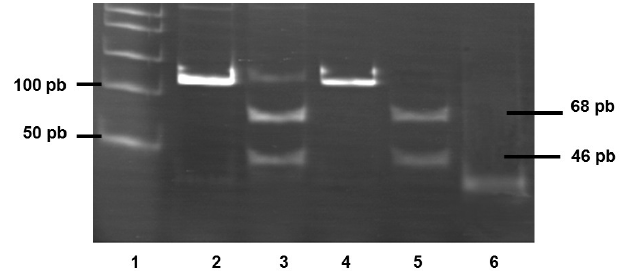
FIGURE 2 - PCR products of FLT3-D835, analyzed by gel electrophoresis. Reverse view of ethidium-bromide-stained 12% polyacrylamide gel FLT3-D835 was detected as extra- band after enzymatic digestion in addition to normal bands of 68 bp and 46 bp. Line 1- Molecular weight marker (50 bp); Line 2-PCR product of a patient sample with FLT3-D835 mutation before enzymatic digestion; Line 3-PCR product of a patient sample with FLT3-D835 mutation after enzymatic digestion ; Line 4-PCR product of a patient sample with wild type before enzymatic digestion; Line 5-PCR product of a patient sample with wild type after enzymatic digestion; Line 6-Water